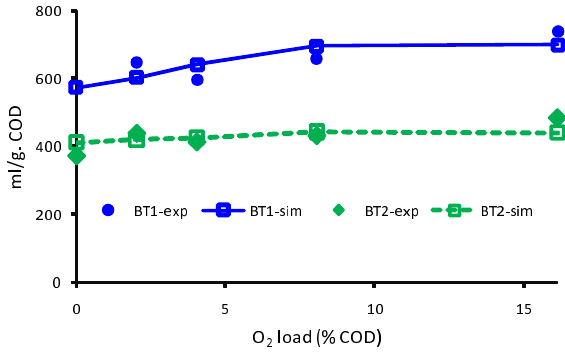
Figure 4: Experimental and simulated CH 4 yields for the test series BT 1 and BT 2